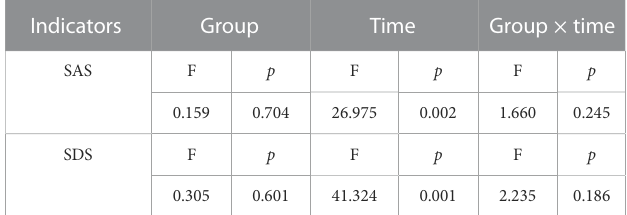
TABLE 2 Two-way repeated measures ANOVA of SAS and SDS.